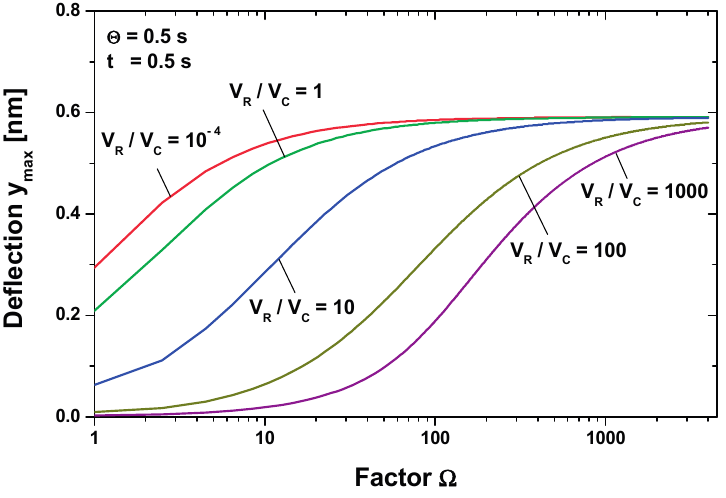
Figure 12. Maximum central deflection, y max , of a circular membrane (silicon, 1 µm thickness) as function of factor Ω and the relation of cavity volume to reservoir volume for a water-filled cavity. IR power density: 10 W/m 2 , irradiation time: 0.5 s, diameter